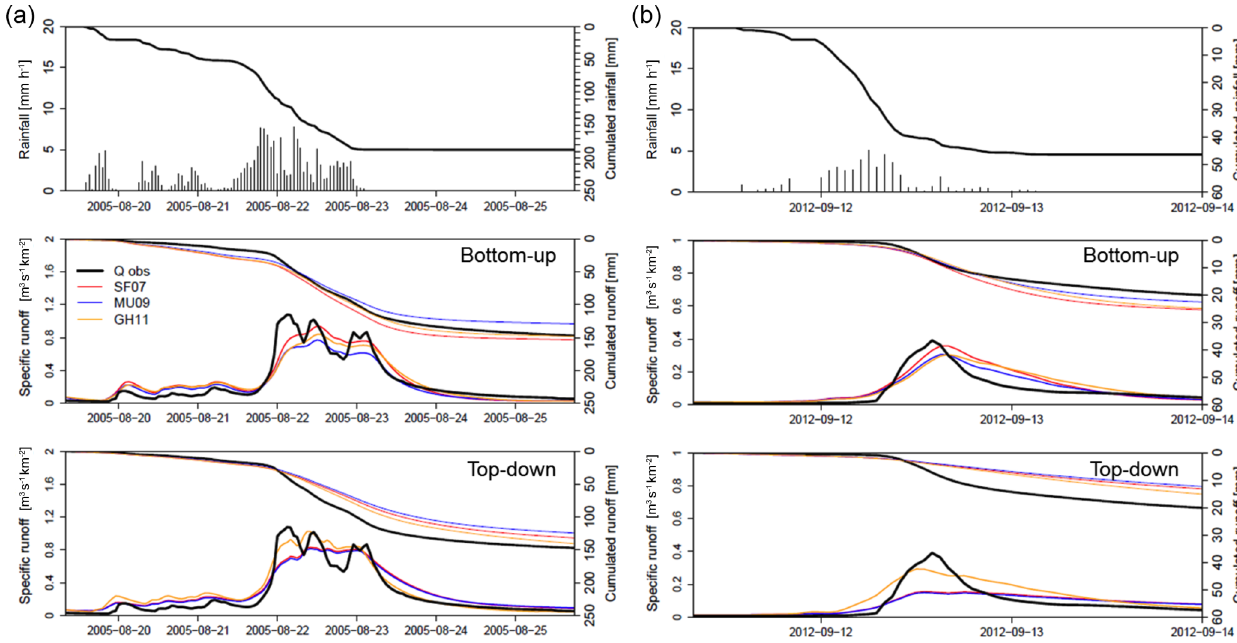
Figure 7. Simulated runoff for the Emme catchment up to Emmenmatt during the long-duration event of August 2005 (a) , and during the short-duration event of September 2012 (b) , obtained from the different process maps and model parameterisations. The simulated hydrographs refer to the first run of the Monte Carlo simulation performed with the corresponding modelling chain combination. The SF07 map reproduced the peak runoff with the bottom-up set-up best, whereas the GH11 map outperformed the other maps with the top-down